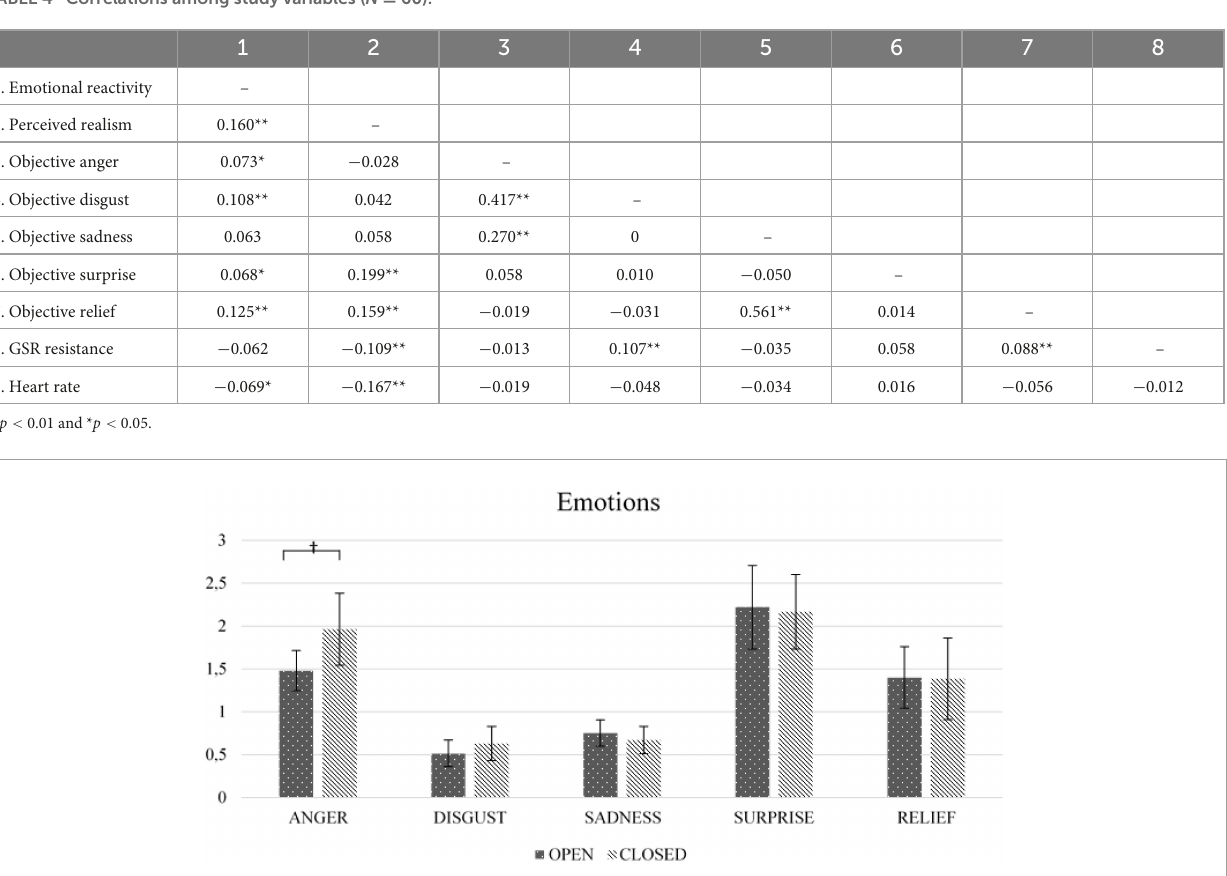
TABLE 4 Correlations among study variables ( N = 60).